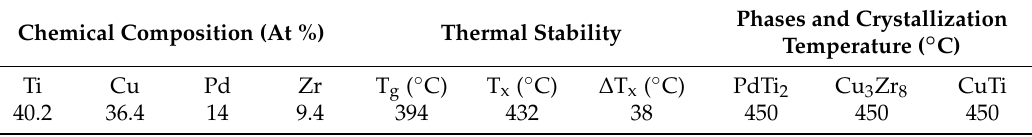
Table 1. Chemical composition and thermal properties of the Ti 40 Zr 10 Cu 36 Pd 14 Bulk Metallic Glass